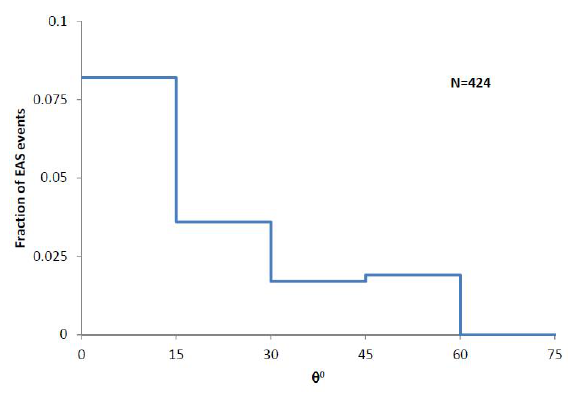
Figure 3. Zenith angle distribution of the shower fraction de- tected with telescope